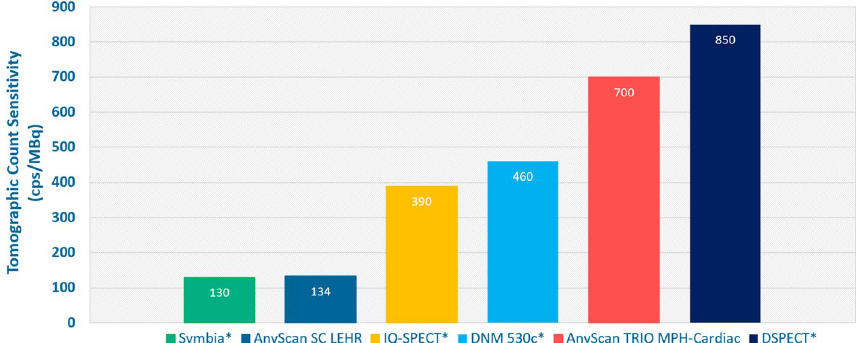
Fig. 6 LV size tomographic count sensitivity (TSorgan) data measured on reconstructed images of the DataSpectrum LV phantom in case of AnyScan SC LEHR and AnyScan TRIO MPH‑Cardiac, compared to several cardiac SPECT imaging systems of different vendors [35].*measured data from publication: Imbert et al. Journal of Nuclear Medicine 2012, 53:1987–1903; https:// doi. org/ 10. 2967/ jnumed. 112.